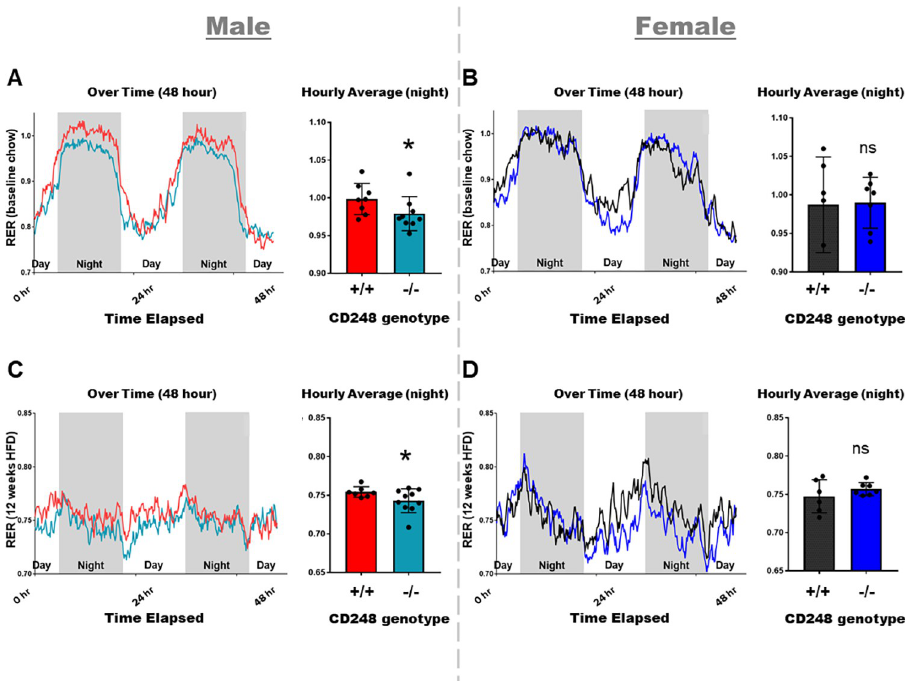
Fig 2. Respiratory exchange ratio (RER) as calculated from indirect calorimetry measurements over 48 hours: Chow- fed (A) males and (B) females; HFD-fed (C) males and (D) females. Line graphs indicate hourly averages over time whilst bar graphs show overall averages at night ± SD. Body weight data over time were analysed for significant differences by t-test. RER data were analysed for significance by ANCOVA test to determine if the body weight covariable is responsible for the significant changes in RER. In all graphs: Cd248 +/+ males (red), Cd248 -/- males (cyan), Cd248 +/+ females (black), Cd248 -/- females (blue). Significant * p � 0.05.